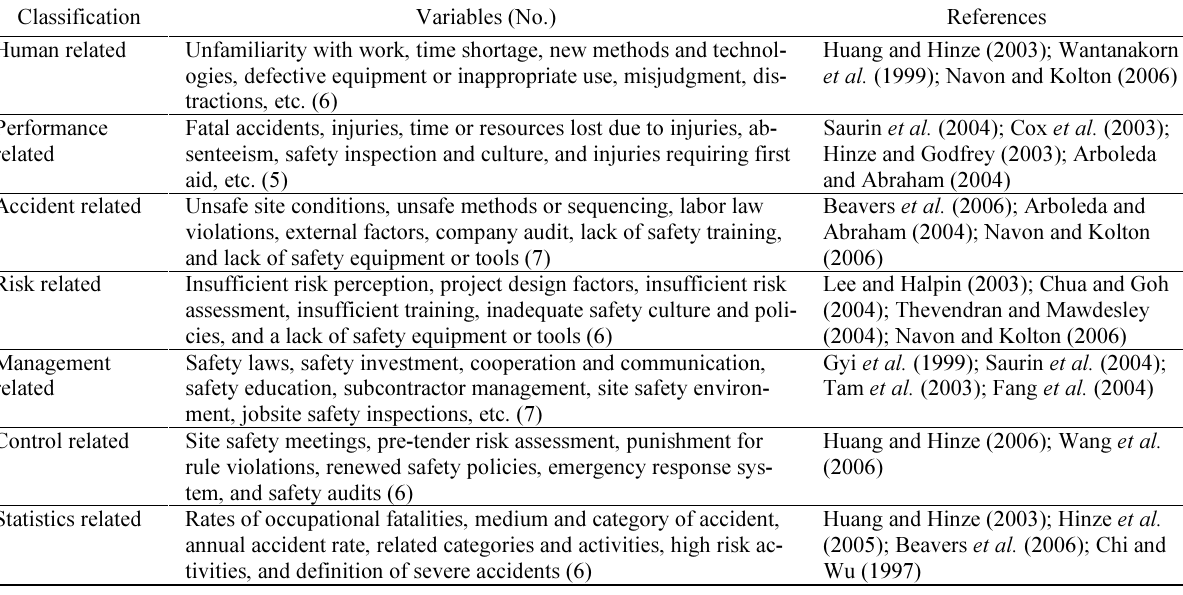
Table 3 . Description of initial variables Classification